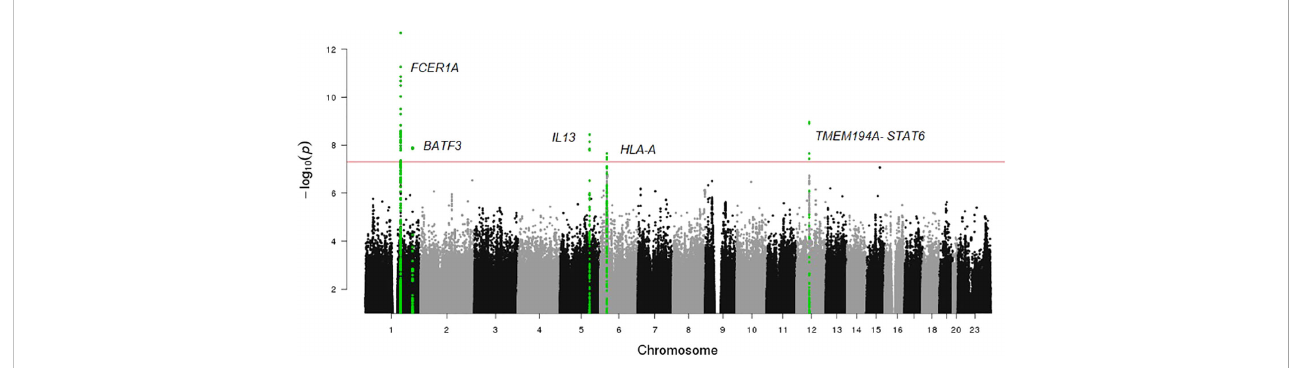
FIGURE 4 Manhattan plot of FHS GWAS results. The horizontal line shows the threshold for genome wide signi fi cance (P-value <5×10 -8 ).